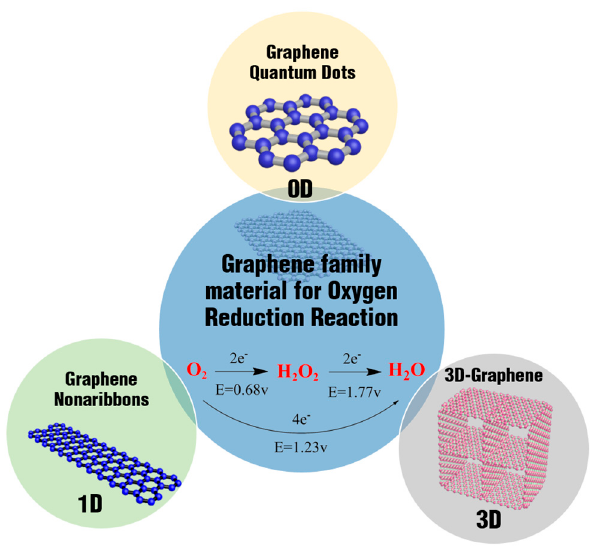
Figure 1. Schematic of graphene family materials of various dimensions for oxygen reduction reaction (ORR).